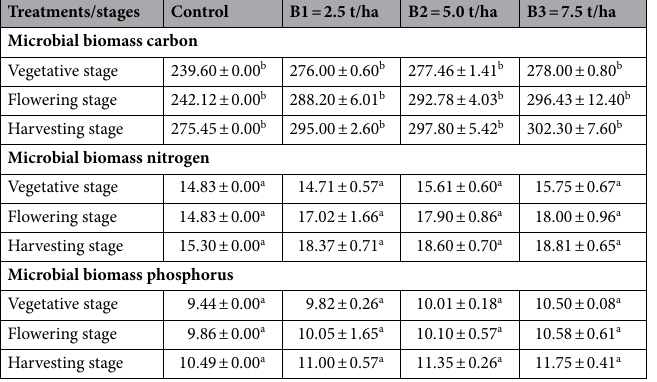
Table 2. Effects of different rates of biochar on microbial biomass (carbon, nitrogen and phosphorous). Means with the same letter in each column of the microbial biomass are not significantly different at p < 0.05, all values in µg g −1 .